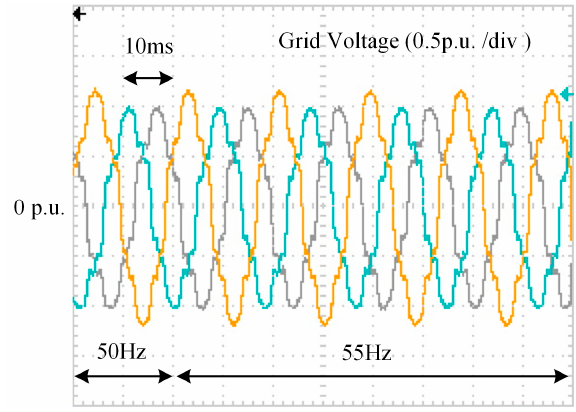
Figure 25. Grid voltages under + 5 Hz frequency step change conditions.